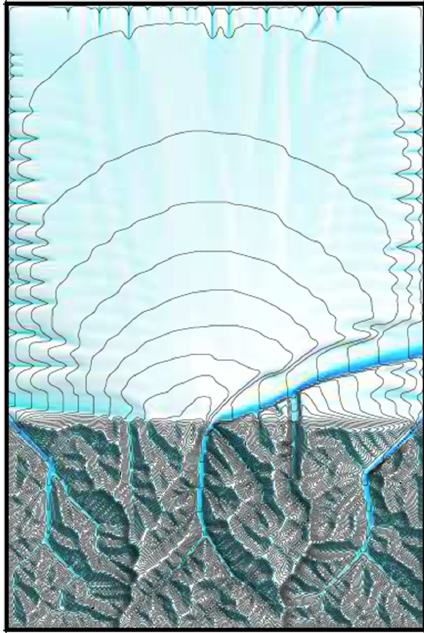
Figure 7. Model configuration at the end ( t = 15.80Myr) of Ex- periment 3a (50m drop in base level at the onset of the incision phase). The megafan is incised by headward incision of a number of streams on its western and eastern borders (and marginally on the northern